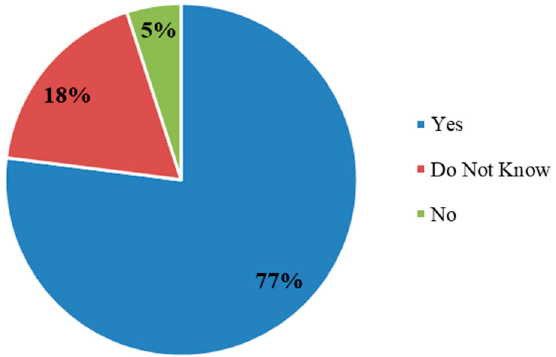
Figure 9. Expert Opinion on the Importance of Proposing Measures to Overcome Challenges.